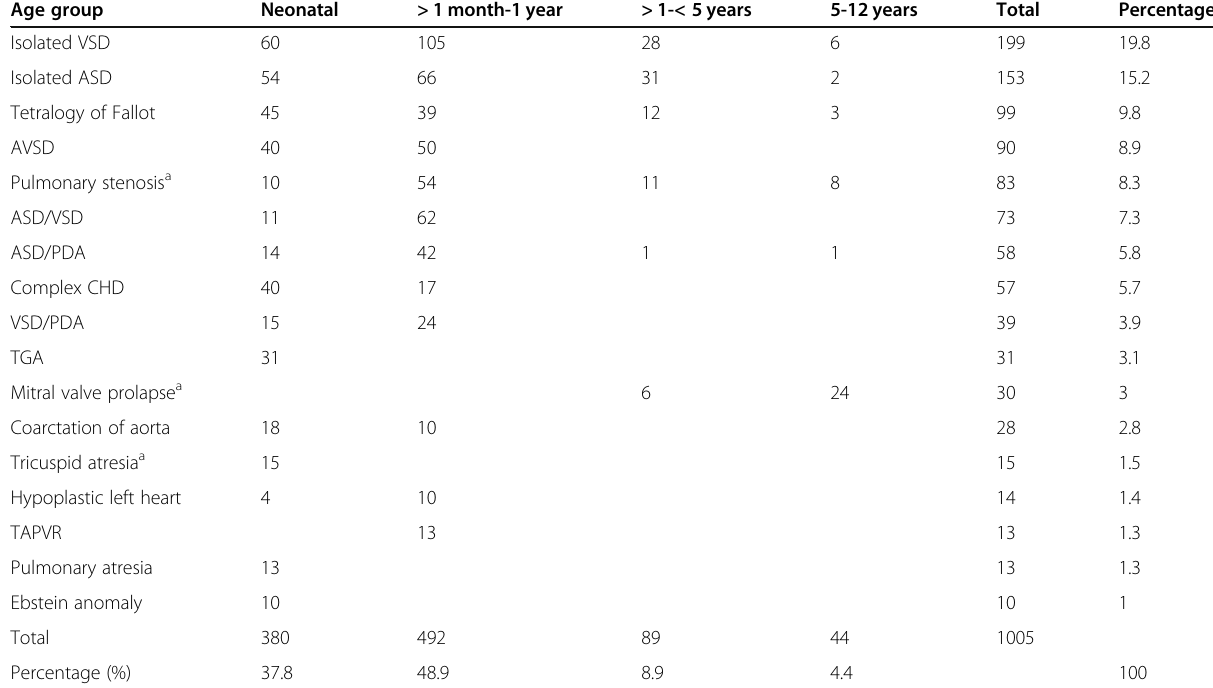
Table 1 Frequency and age-wise distribution of types of